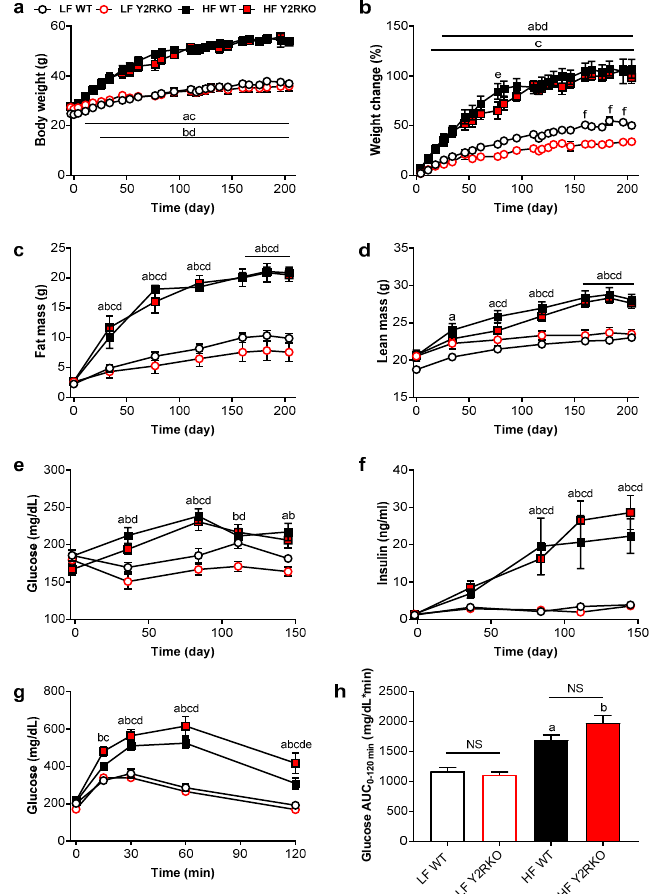
Figure 1. Body weight, body composition, fasting glucose and insulin and glucose tolerance of male wildtype (WT) and Y2R-deficient (Y2RKO) mice on either low-fat (10%; LF) or high-fat (60%; HF) diet. Absolute ( a ) and percent change ( b ) in body weight; total fat mass ( c ) and lean mass ( d ); fasting blood glucose ( e ) and plasma insulin ( f ) and intraperitoneal glucose tolerance test (1.5 g/kg) ( g ) with associated area under the curve analysis ( h ). n = 10/group. a p ≤ 0.05 LF WT vs. HF WT, b p ≤ 0.05 LF Y2RKO vs. HF Y2RKO, c p ≤ 0.05 HF WT vs. LF Y2RKO, d p ≤ 0.05 LF WT vs. HF Y2RKO, e p ≤ 0.05 HF WT vs. HF Y2RKO, f p ≤ 0.05 LF WT vs. LF Y2RKO.